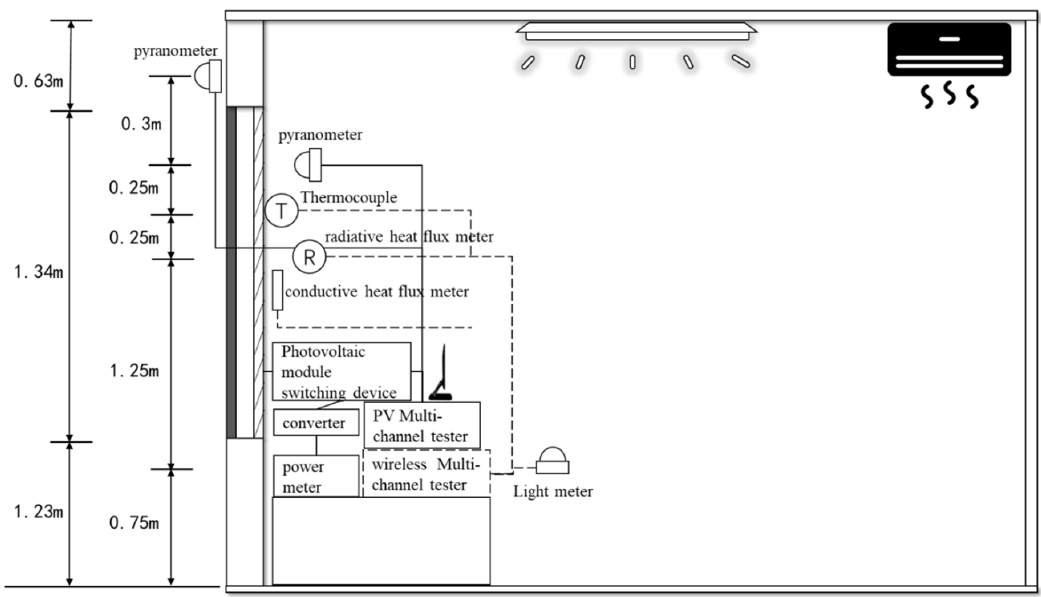
Figure 4. Schematic diagram of the indoor environment test instruments.